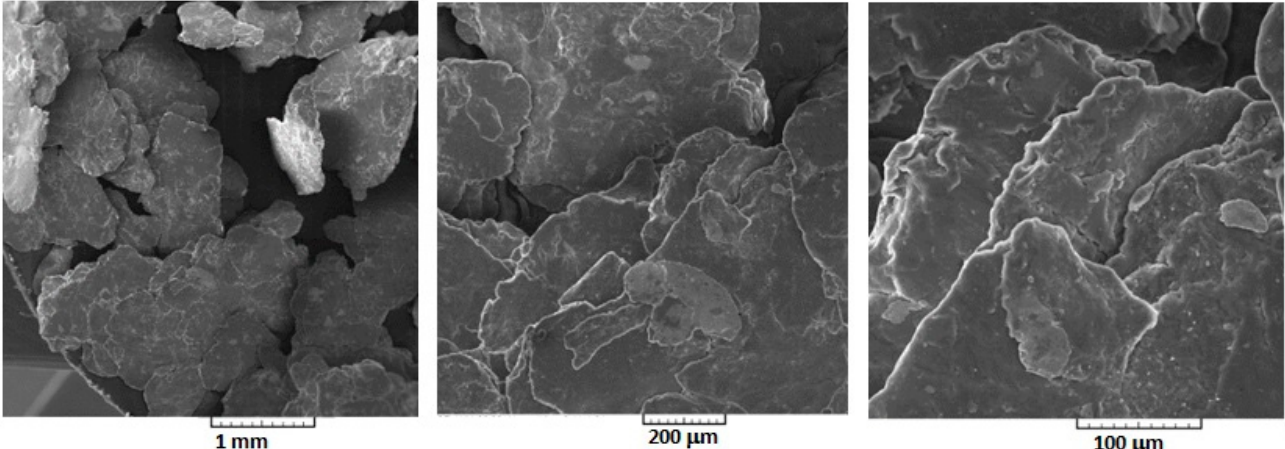
Figure 4. The Mg ‐ 10Zn ‐ 0.8Ca ‐ 0.5Zr (wt.%) alloy ‐ powder processed by mechanical alloying with 200 rpm/6 h/10:1.